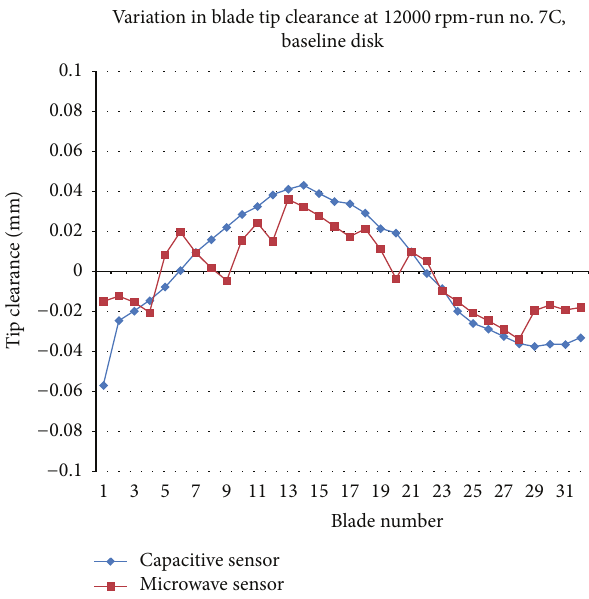
Figure 3: Sample of capacitive and microwave sensor data readings for a baseline disk at 12000rpm.